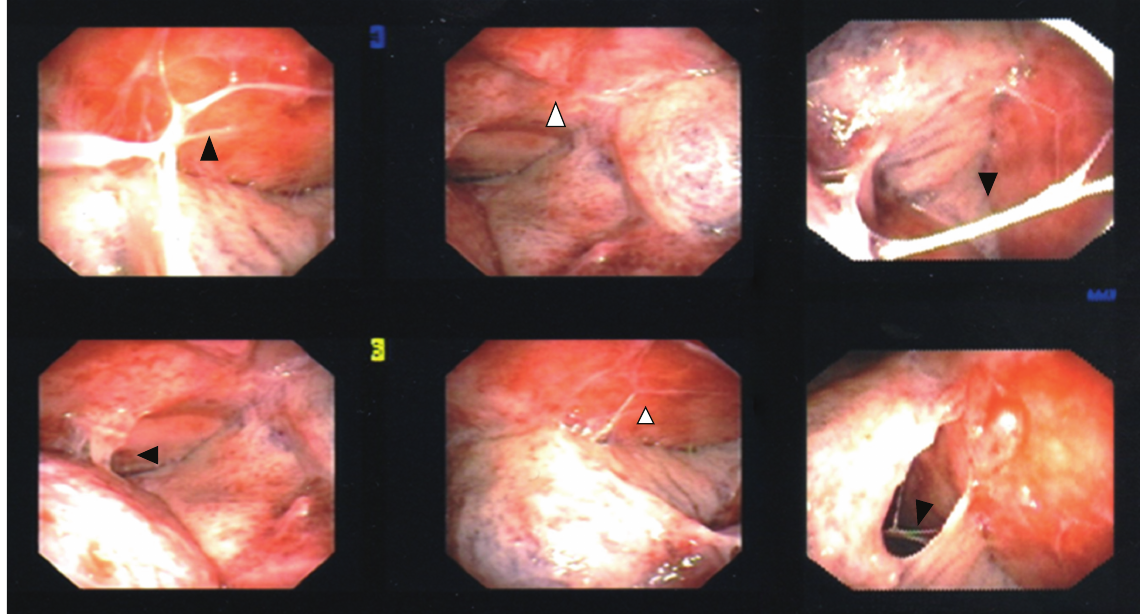
Figure 4: Thoracoscopic views of a complicated parapneumonic e ff usion. Multiple pleural adhesions (black arrowheads) are seen which prevent lungs from re-expanding. There are also seen inflamed pleura (white arrowheads) which represent nonresolving